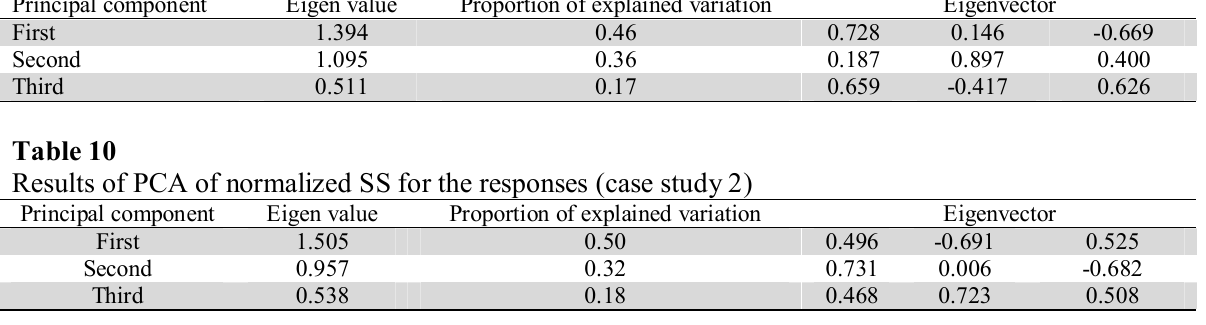
Results of PCA of normalized SN ratios for the responses (case study 2) Principal component Eigen value Proportion of explained variation Eigenvector First Second